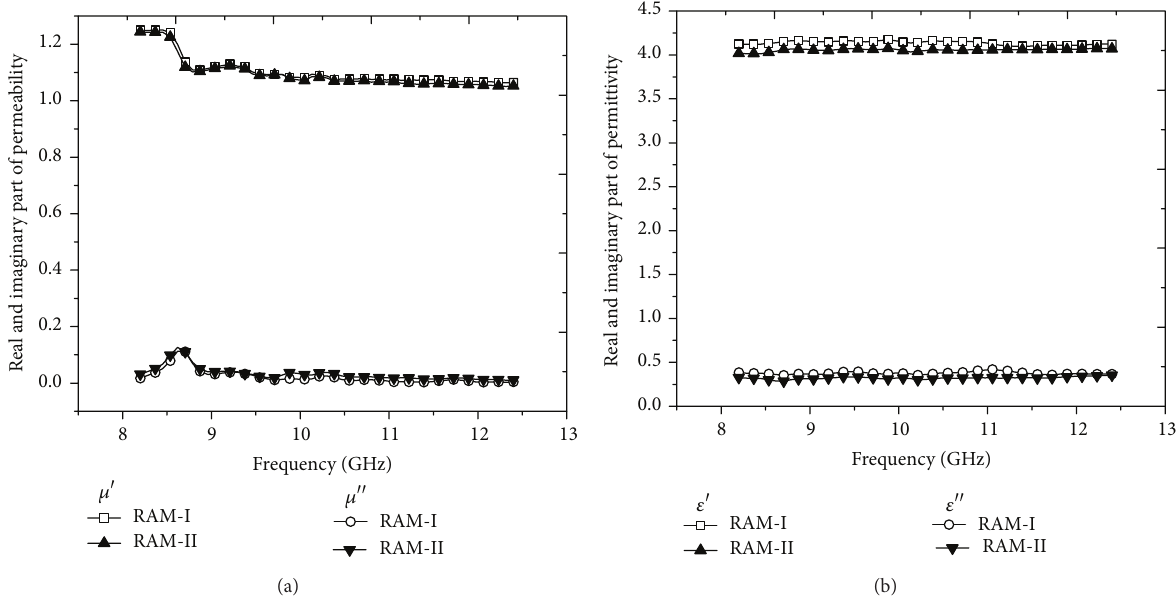
Figure 4: (a) Real and imaginary part of permeability for RAMs (I and II), (b) real and imaginary part of permittivity for RAMs (I and II).